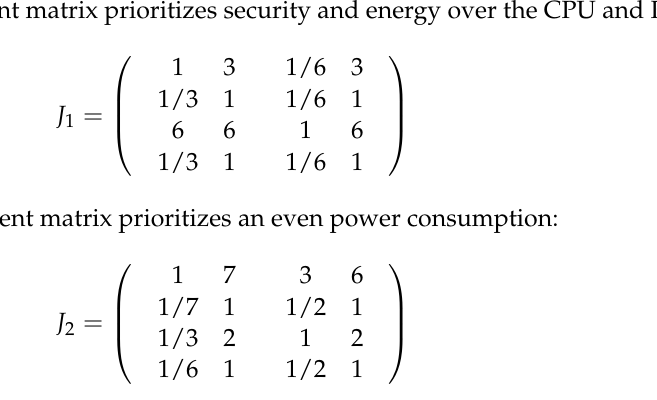
Sense1 Sense2 Actuate2 Process1